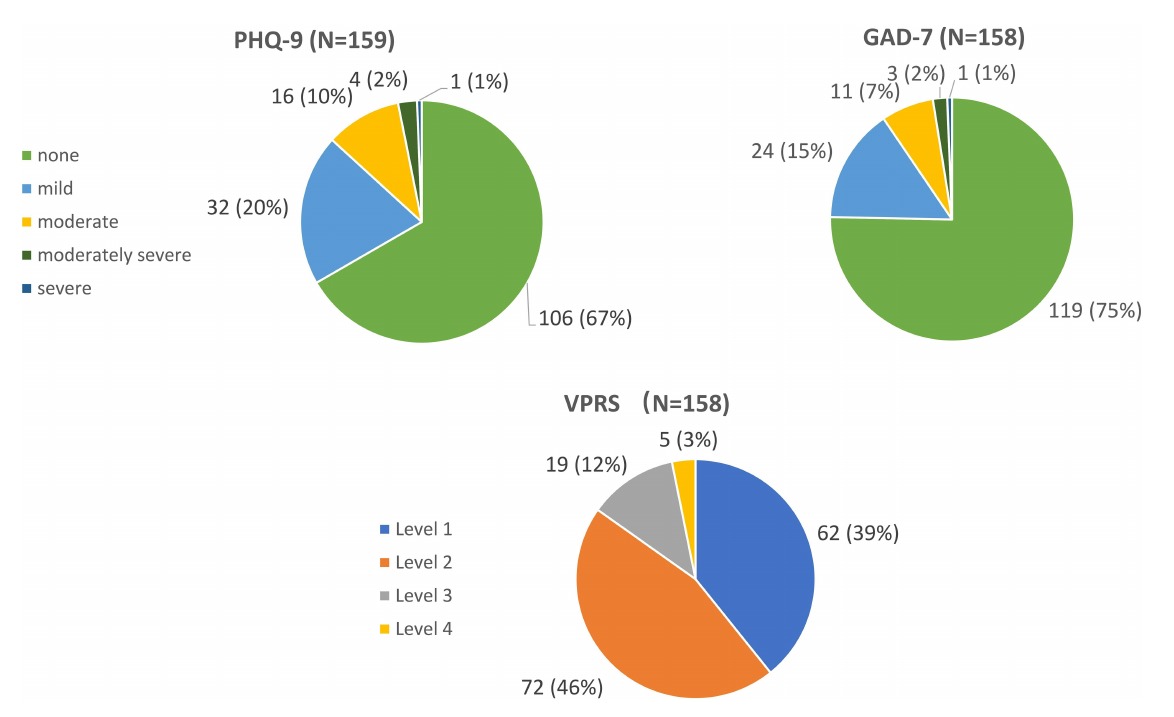
FIGURE1 Patients with multiple myeloma during maintenance therapy were scored in PHQ-9, GAD-7, and